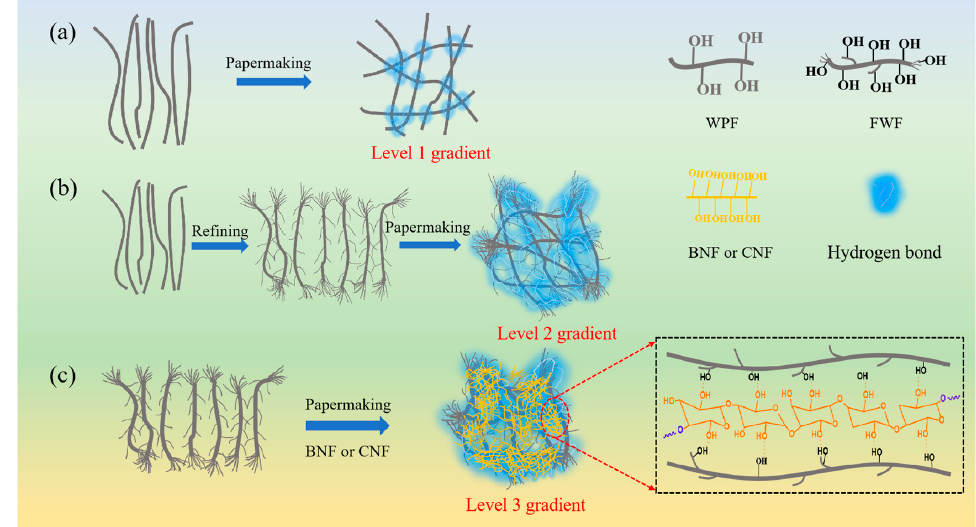
Figure 1. Fiber gradient reinforcement mechanism diagram. ( a ) Level one gradient skeleton support network formed by WPF fibers. ( b ) Level two gradient reinforced structure formed by WPF after pulping and papermaking. ( c ) Level three gradient-enhanced mesh structure formed by mixing FWF and BNF/CNF for